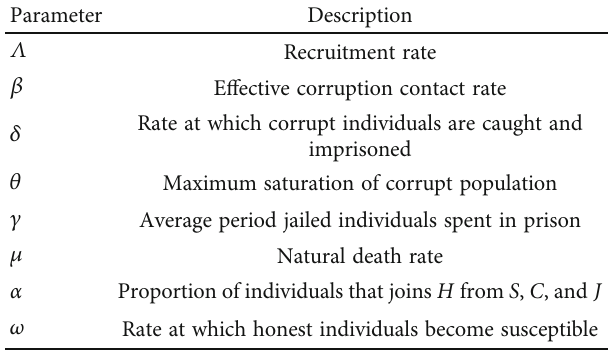
Table 1: Parameters of the